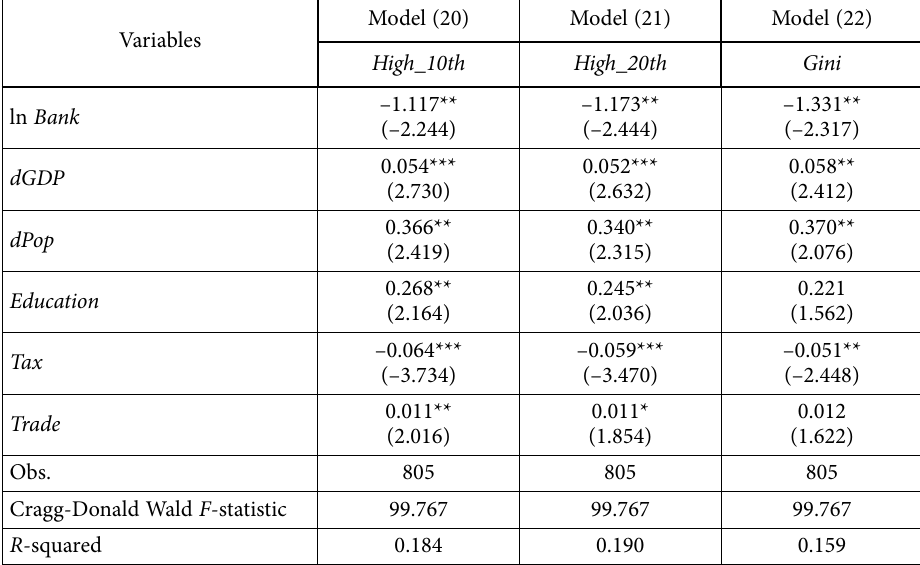
Table 6. Results using instrumental